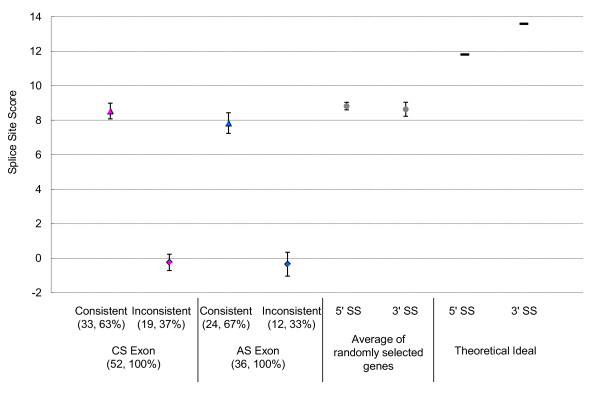
Splice site scores shown by exon type and consistency between allele prediction and the GT-AG rule. The average splice site scores for four categories, defined by whether predicted alleles were consistent with the GT-AG rule (consistent; triangle) or not (inconsistent; diamond), and whether they were located at a GT-AG site adjacent to CSE (pink symbol) or to ASE (blue symbol). Numbers in parentheses are numbers of cases and percentages. The six sdSNPs in CE dinucleotides are included in both consistent and inconsistent categories. Averages of randomly selected genes were calculated using values for ARG2 and CFTR genes (gray symbol) in Table 2 of reference [59]. These splice scores were calculated using MaxEntScan [56,57], and theoretically ideal scores are given in reference [59].